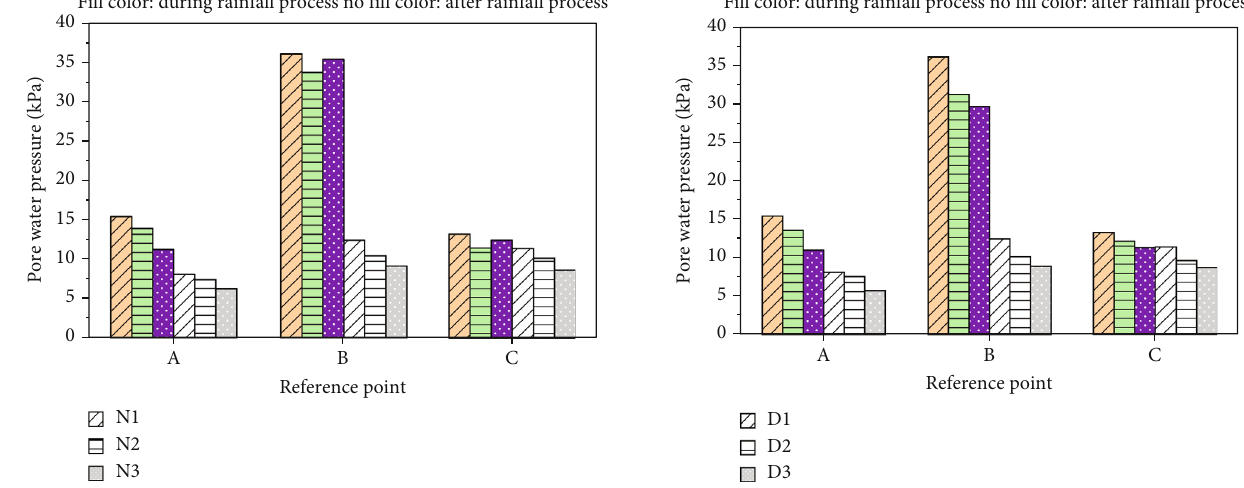
Figure 22: Di ff erent values of pore pressure at the reference points for di ff erent vegetation